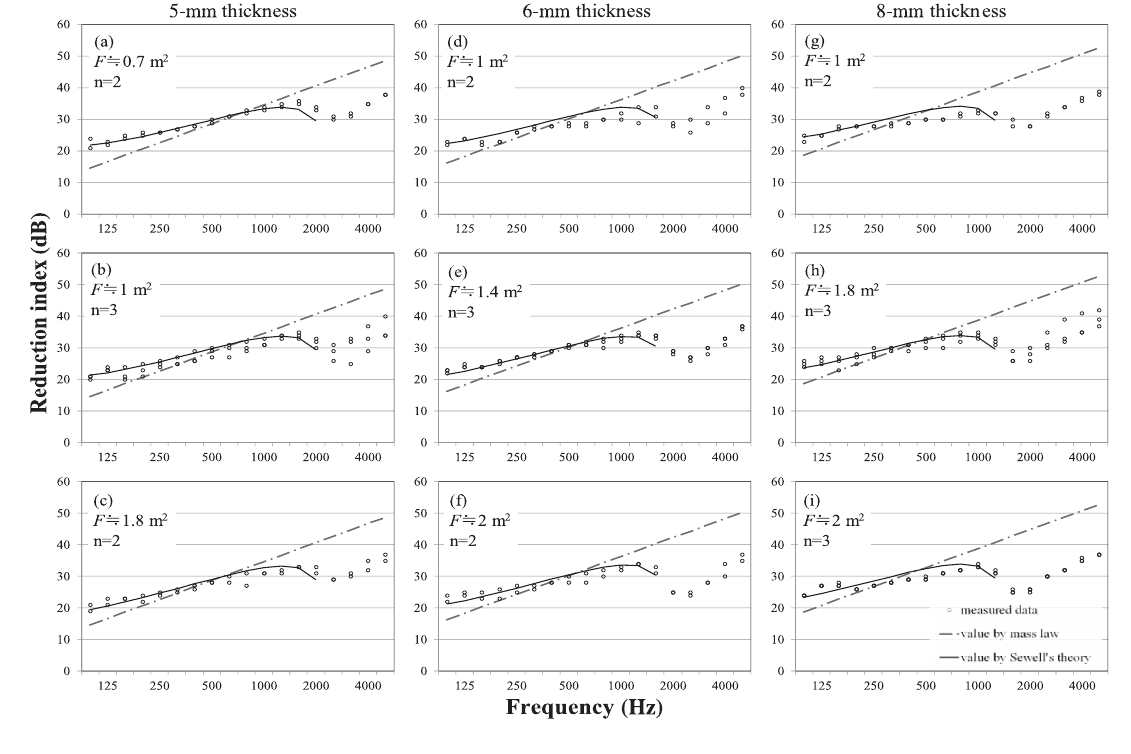
Reduction indices of the projected window with theories. Solid lines and dash–dotted lines, respectively, represent values using Sewell’s theory and values using the mass law. Plots show measured data of windows in the 1/3 octave. ‘F’ and ‘n’ represent the window area and the number of the samples,